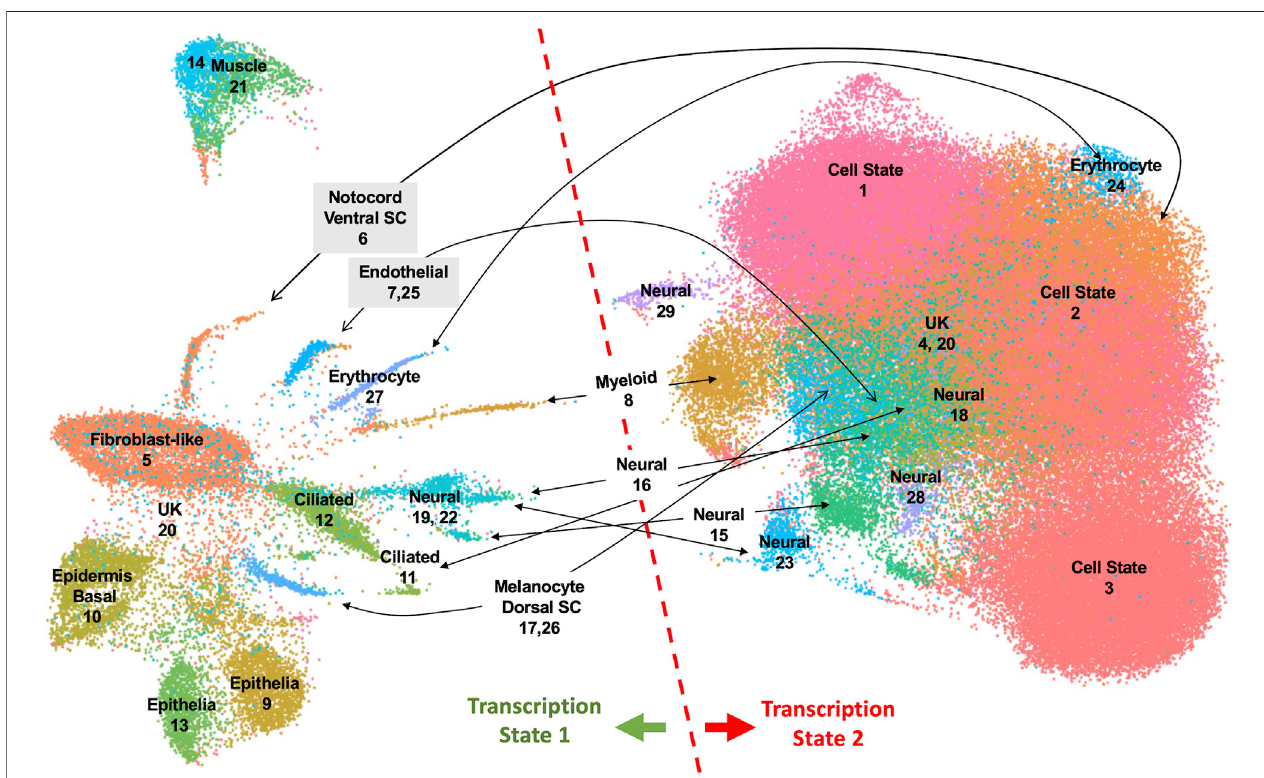
FIGURE 4 | UMAP projection of 133,193 nuclei isolated from axolotl embryo tail tips and characterized by single nuclei RNA-Seq. Twenty-nine clusters were identi fi ed from an analysis of nuclei isolated from control 0 HPA, 6 HPA, and romidepsin 6 HPA embryos. Clusters were annotated to cell types when possible. Nuclei in the left half of the UMAP projection expressed repetitive sequence transcripts and chromatin-modifying factors more highly than nuclei in the right half.